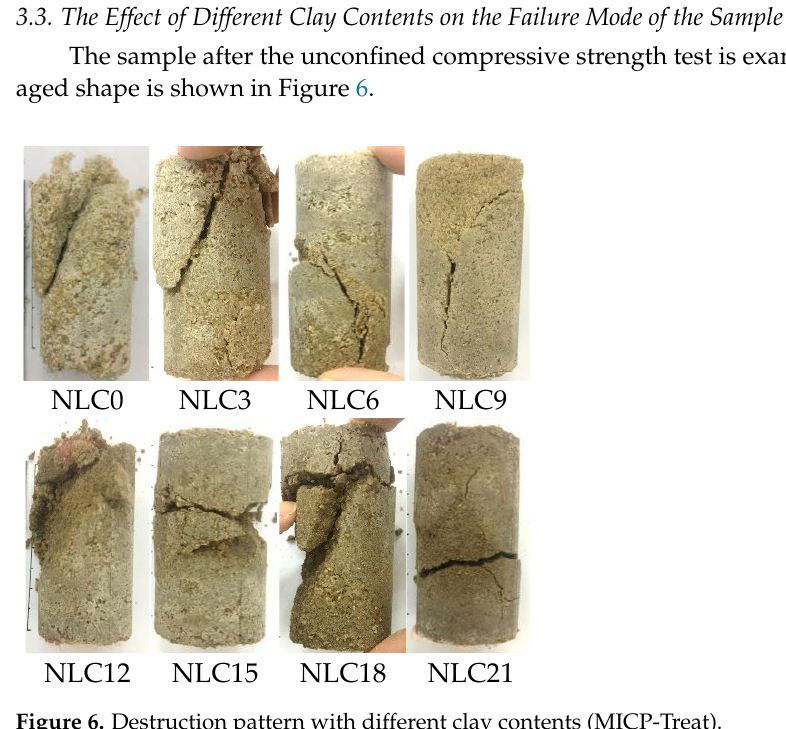
Figure 5. UCS and failure strain with different clay contents (MICP-Treat).